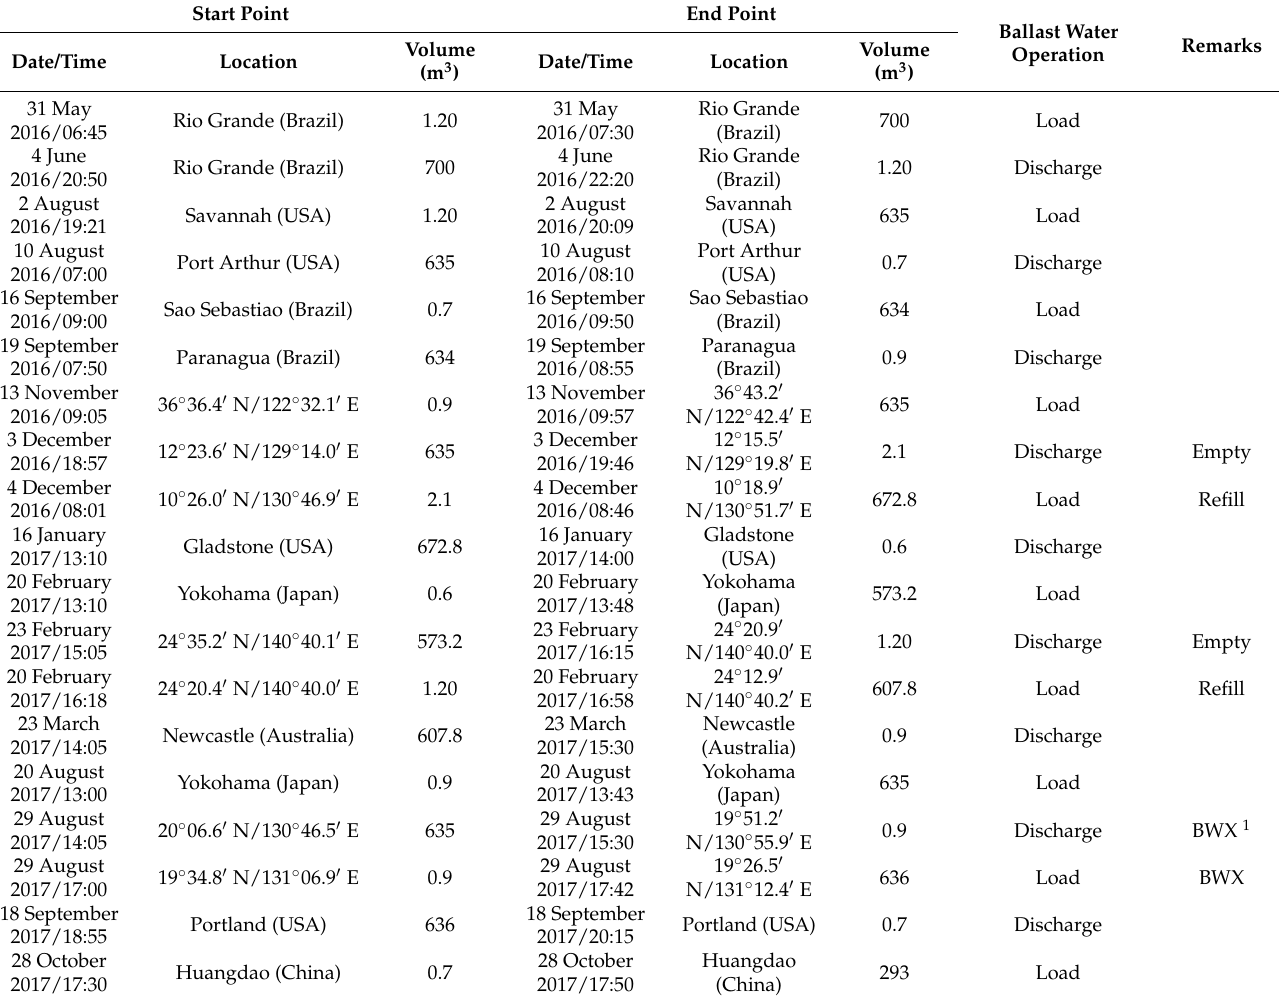
Table 1. The ballast water log for the studied ballast tank of Vessel